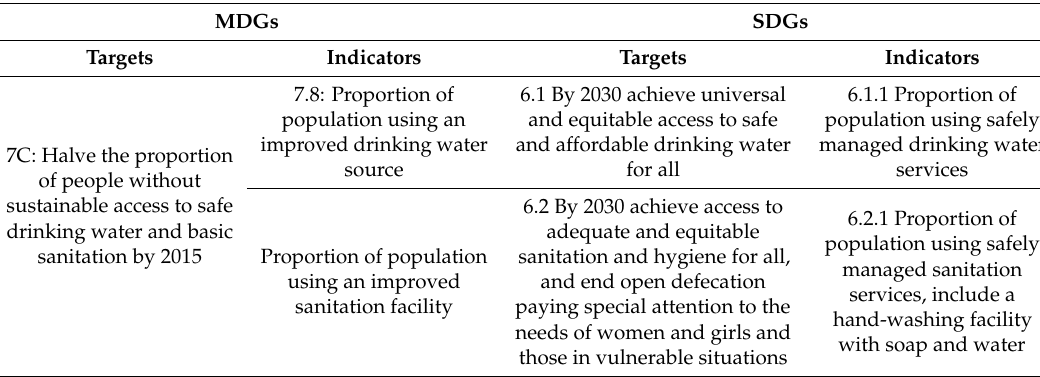
Table 1. The evolution from the Millennium Development Goals (MDG) to the Sustainable Develop Goals (SDG) sees an increase in expectations. These expectations are set out in the SDG6 targets and indicators.